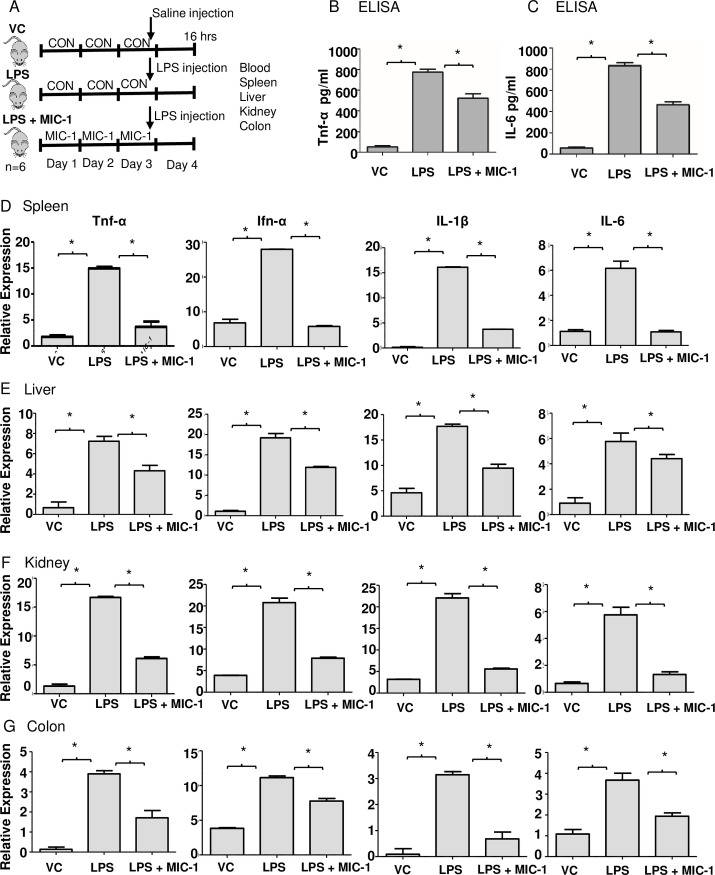
MIC-1 ameliorates LPS-induced sepsis/inflammation.(A) Schematic representation of the experimental design. Male C57BL/6 mice (n  =  18) were randomly divided into three groups: vehicle control (10% DMSO); LPS (10 mg/kg); LPS (10 mg/kg) + MIC-1 (80 mg/kg). LPS or saline control treatment was given after 3 d of gavaging MIC-1, and blood and organs collected after 16 h post LPS administration (n = 6). The levels of serum Tnf-α (B) and IL-6 (C) were determined using ELISA kits (n = 6). Tnf-α, Ifn-α, IL-1β, and IL-6 mRNA levels in the spleen (D), liver (E), kidney (F), and colon (G) measured with qPCR. Error bars indicate ± S.D. (n = 6). * indicates the data was significant at P ≤ 0.05.